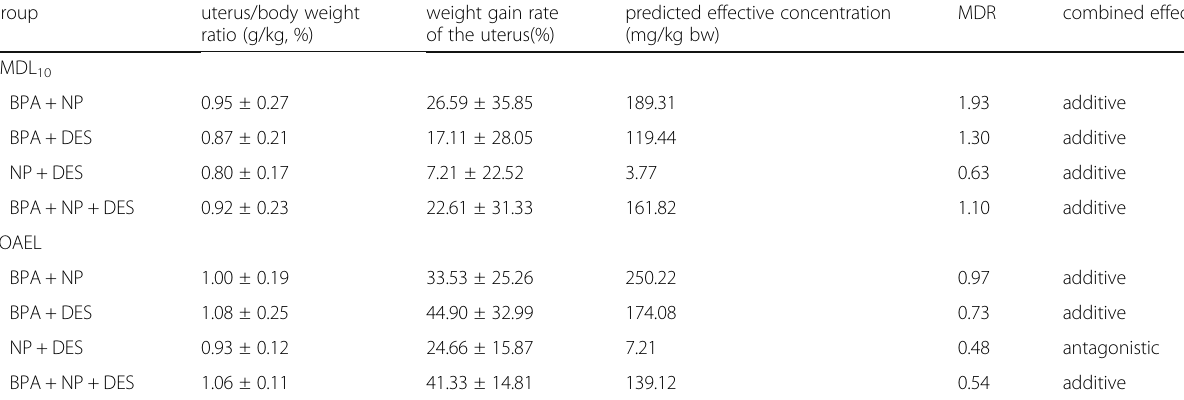
Table 3 The MDRs between predeiction and tested results of uterus/body weight ratio treated with combination of BPA, NP and DES